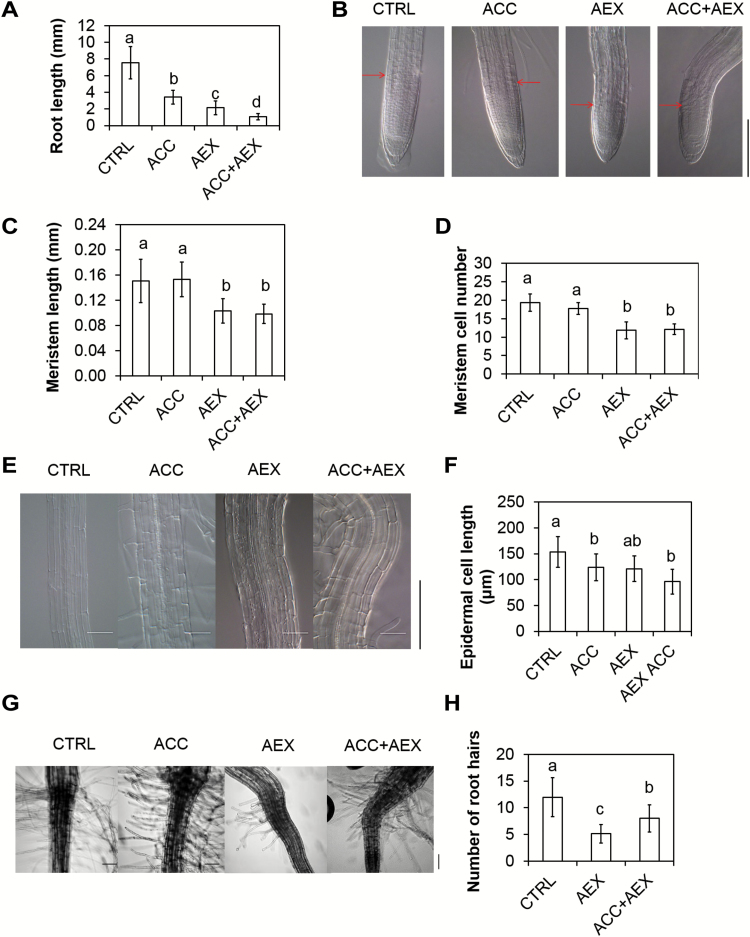
Inhibitory effect of AEX on root growth of 4-day-old etiolated Col-0 seedlings grown on vertically standing plates. (A) Root length. (B) DIC microscopy images of the root tip. The last cortical cells of the root meristem are marked with an arrow. Individual photographs were cropped without changing the scale. (C) Meristem length. (D) Meristem cell number. (E) DIC microscopy images of the root elongation zone. (F) Epidermal cell length in the root elongation zone. (G) Bright-field microscopy images of roots near the hypocotyl–root junction. (H) Total number of root hairs from one epidermal cell file. Data are presented as means±SD. Statistical analysis was performed by means of a Kruskal–Wallis test with root length (13>n>44; A), meristem length (13>n>17; C), meristem cell number (18>n>23; D), epidermal cell length (9>n>15; F) or number of root hairs (15>n>23; H) compared among treatments. Multiple pairwise comparisons were performed with post hoc Wilcoxon’s rank sum tests (P<0.05); P-values were adjusted with the Bonferroni correction. Bars with at least one letter in common are not significantly different. All experiments were performed at least twice and results from a representative experiment are shown. Scale bars: 100 µm. (This figure is available in color at JXB online.)